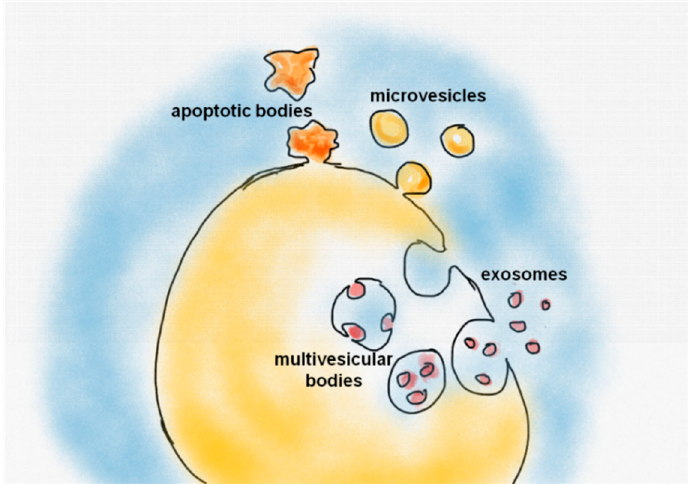
Figure 1. Schematic representation of the different type and biogenesis of extracellular vesicles. Figure not in real proportions scale.